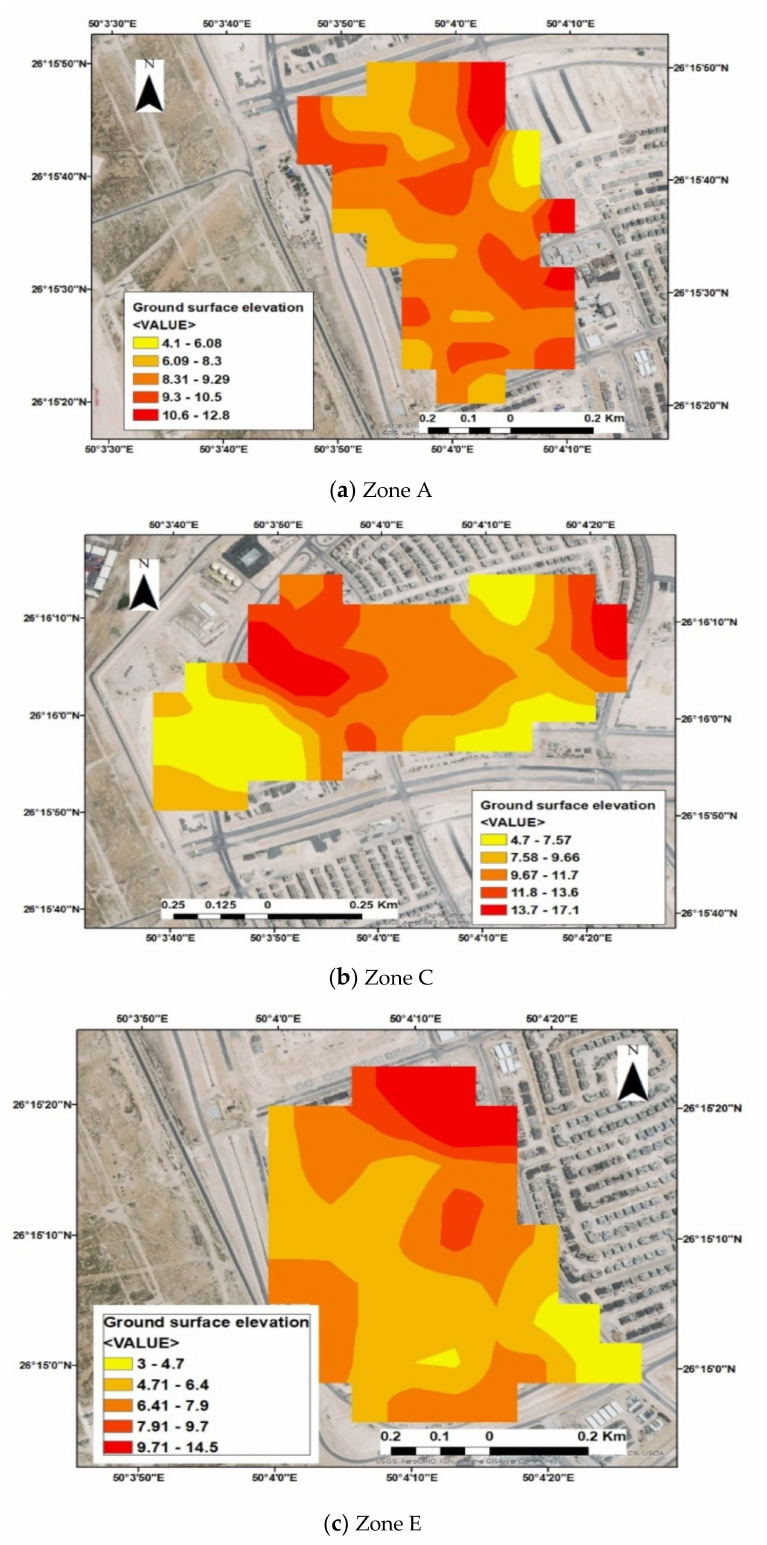
Figure 2. Ground surface elevation of zones A ( a ), C ( b ) and E ( c